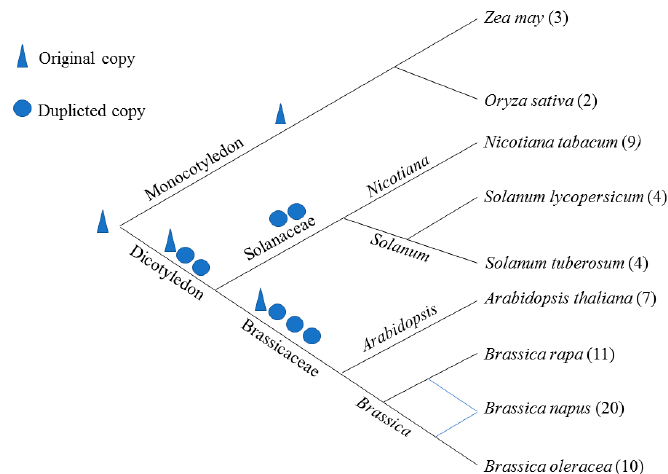
Figure 3. Inferred origin and evolutionary relationship of GolS genes and their copy number change among nine plants. The digits represent the number of GolS genes in plants species. Triangle represents the original genes of GolS in plants, while the circle represents the duplicated genes. The blue line indicates that B. napus is formed by B. rape and B. oleracea .